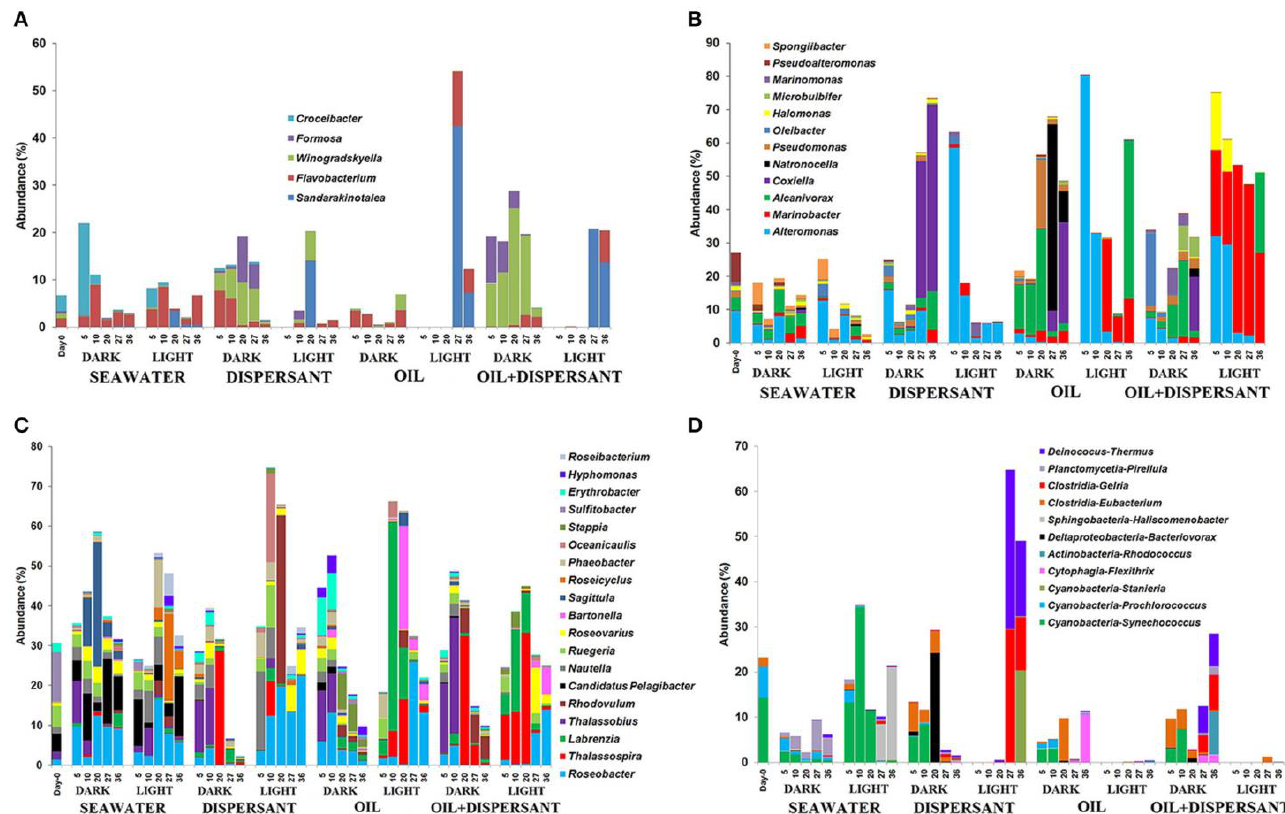
Figure 6. Abundances of bacteria at genus level in seawater alone, seawater with dispersant Corexit, crude oil, and both oil and dispersant incubated under the dark and light conditions for 36 days. Only abundances greater than 5% in at least one of the samples are shown. ( A ) Flavobacteria, ( B ) Gammaproteobacteria, ( C ) Alphaproteobacteria, ( D ) Other bacteria. The numbers indicate days of incubation. (Adapted from Bacosa et al. [84].)